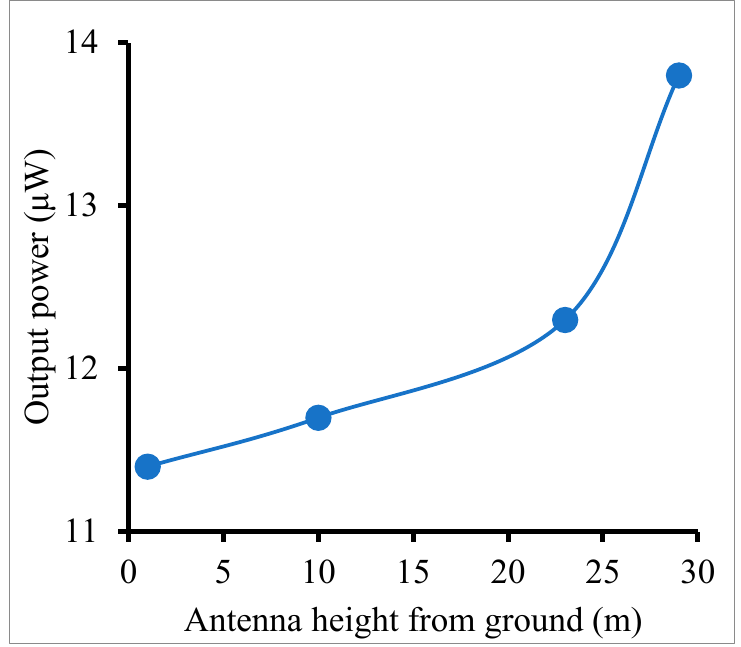
Figure 10. Output power with antenna height from ground. Other parameters were constant with those in Figure 8.